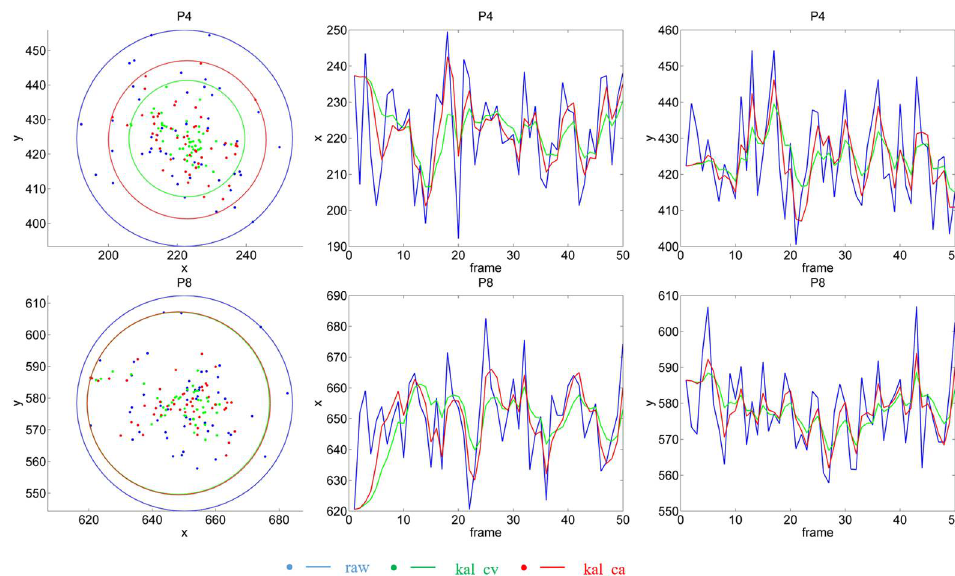
Figure 10. POR results of P4 and P8. The upper and lower rows present the results of P4 and P8, respectively. The left column is the actual POR, each dot represents a POR, and the circle represents the smallest covered circle, with the mean of the PORs as the center. The middle and right columns present the x- and y-values of each POR, respectively.